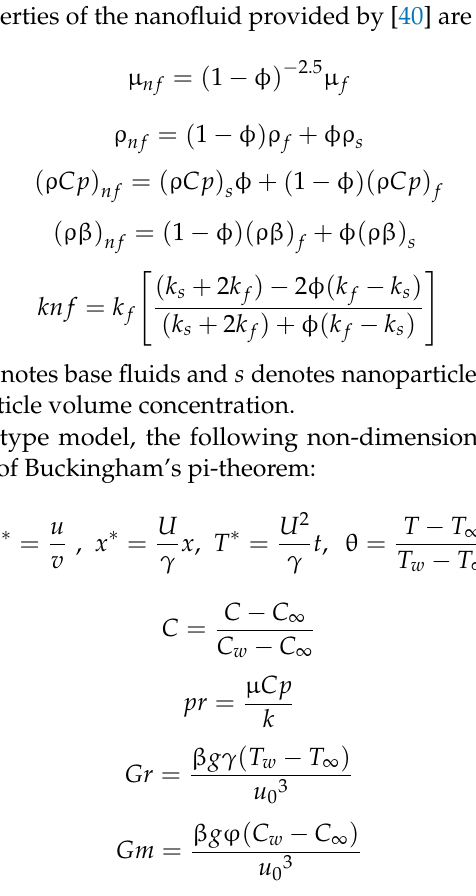
Figure 1. ( a ) . Flow configuration; ( b ) flow chart of solving the fluid flow model of the present work.